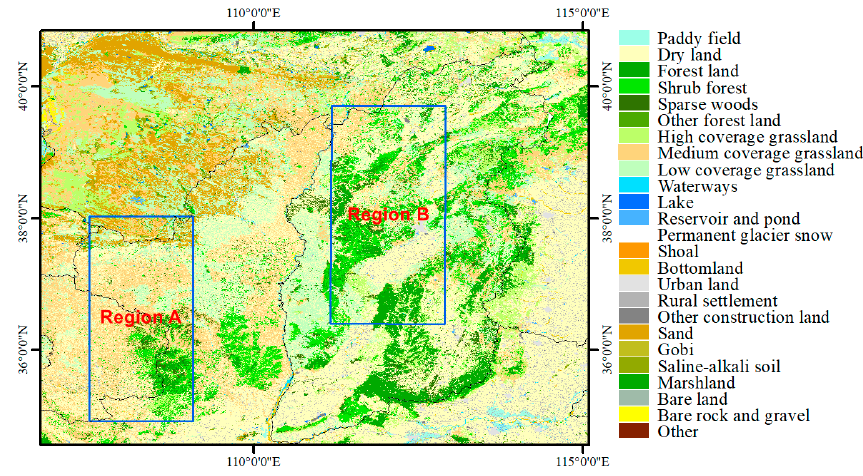
Figure 9. The locations of regions A and B in the study area.